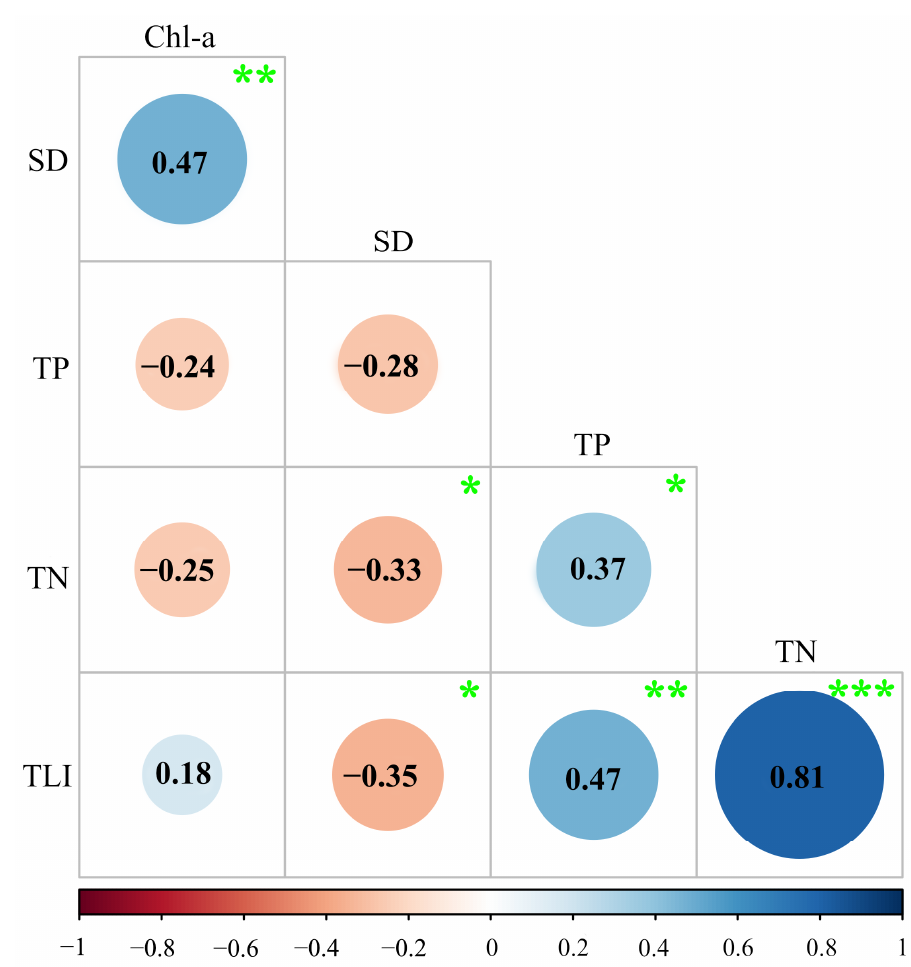
Figure 4. Correlation among water quality indices (green ***, ** and * mean significant correlation at the 0.001, 0.01 and 0.05 levels; the number in the circle refers to Pearson correlation coefficient).